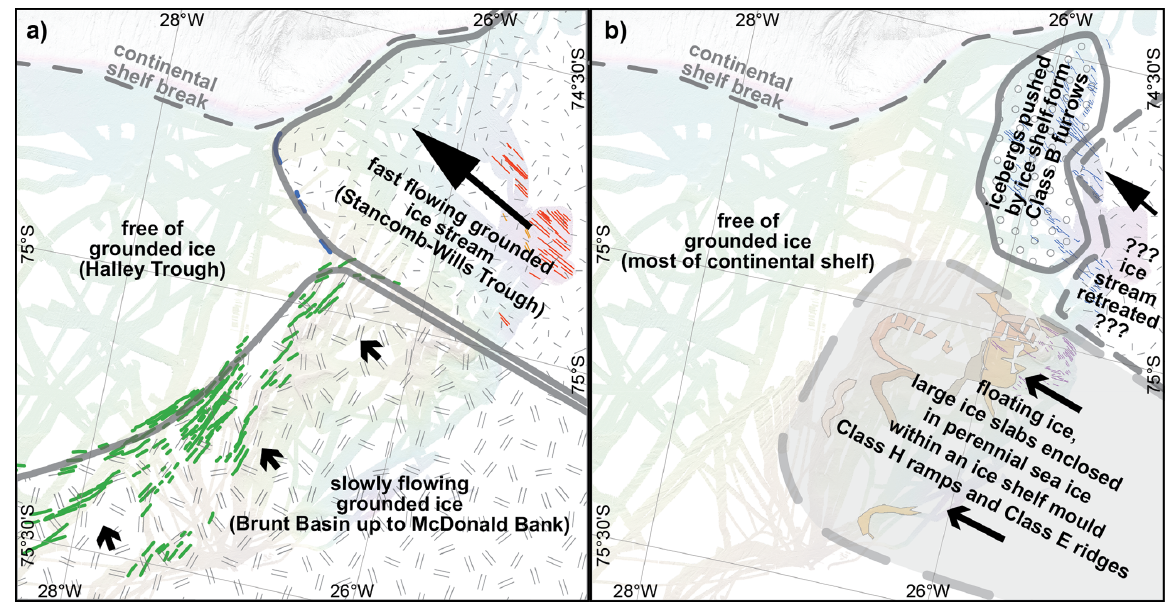
Figure 11. Schematic illustrating the two reconstructed glaciological regimes in Brunt Basin and on McDonald Bank: (a) the first regime with slow-flowing grounded ice forming Class I ridges at its margin and (b) the second regime in which large ice slabs mould Class H ramps and Class E ridges. Background and landforms relevant for the respective regimes correspond to Fig.